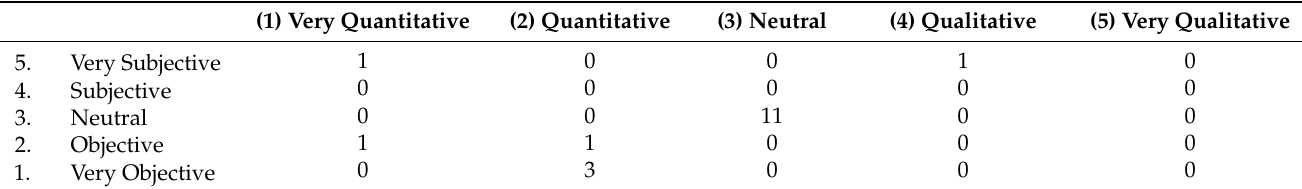
Table 3. Author 1 sources (18 sources).